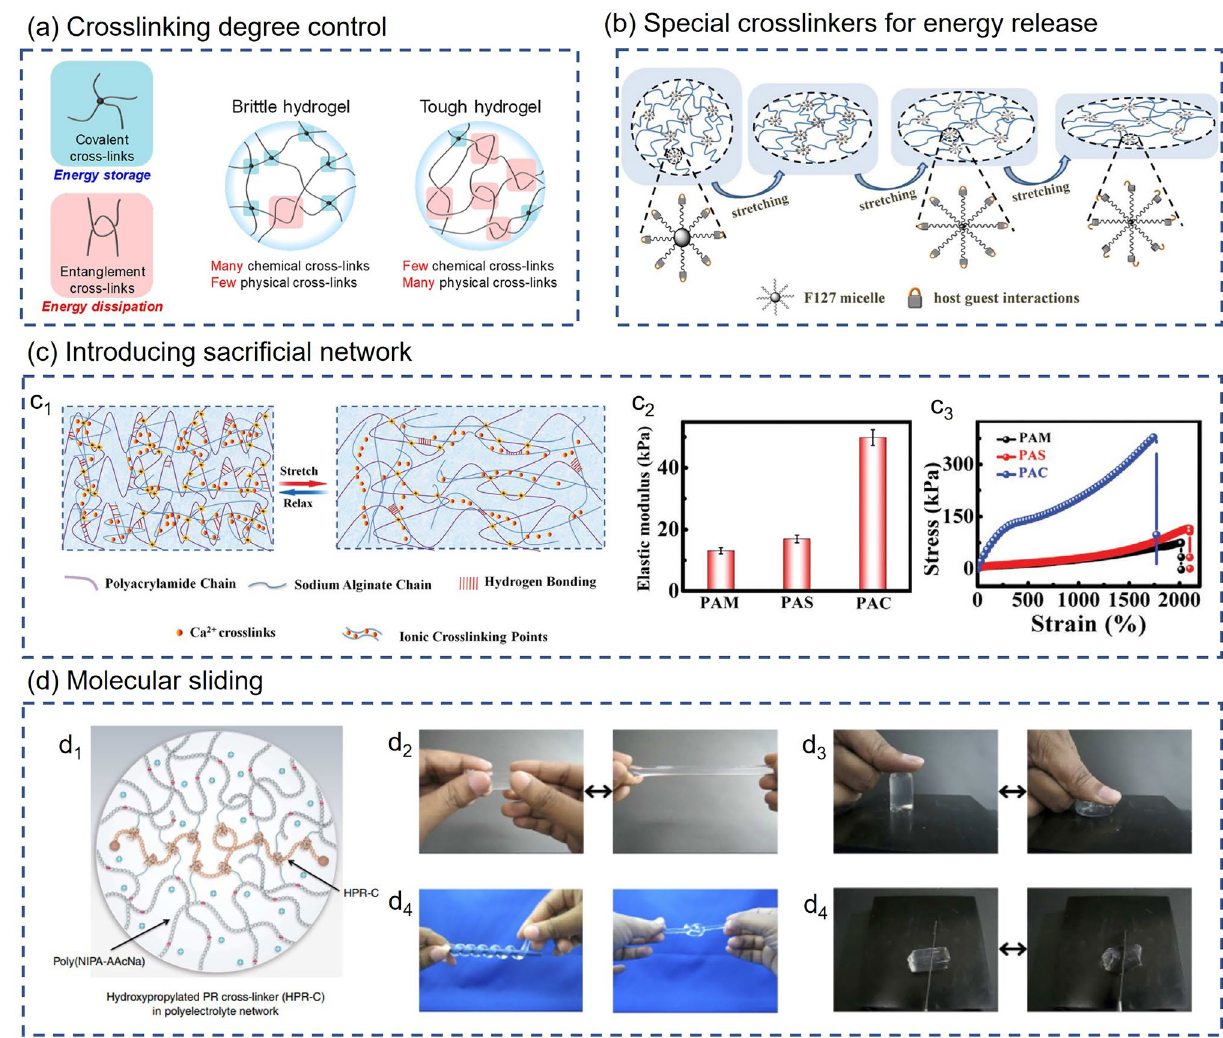
Fig. 3 Mechanisms of regulating mechanical properties of hydrogels. a Cross-linking degree control. (Left) Covalent and entanglement cross- links inside the hydrogel play the roles of energy storage and dissipation. (Right) Differences in cross-linking structures of brittle and tough hydrogels [81]. Reproduced with permission. Copyright 2021, The Author(s), Springer Nature. b Special cross-linkers for energy release [82]. The energy release mode of F127AZO@β-CD multi-functional cross-linkers during stretching process. Reproduced with permission. Copyright 2018, American Chemical Society. c Introducing sacrificial network [85]. c 1 Schematic diagram of the variation of the double network in the PAC hydrogel under stretching and releasing. c 2 Comparison of the tensile stress–strain curves of PAM, PAS and PAC hydrogels. c 3 Elastic modulus of three kinds of hydrogels. Reproduced with permission. Copyright 2019, John Wiley and Sons. d Molecular sliding [87]. d 1